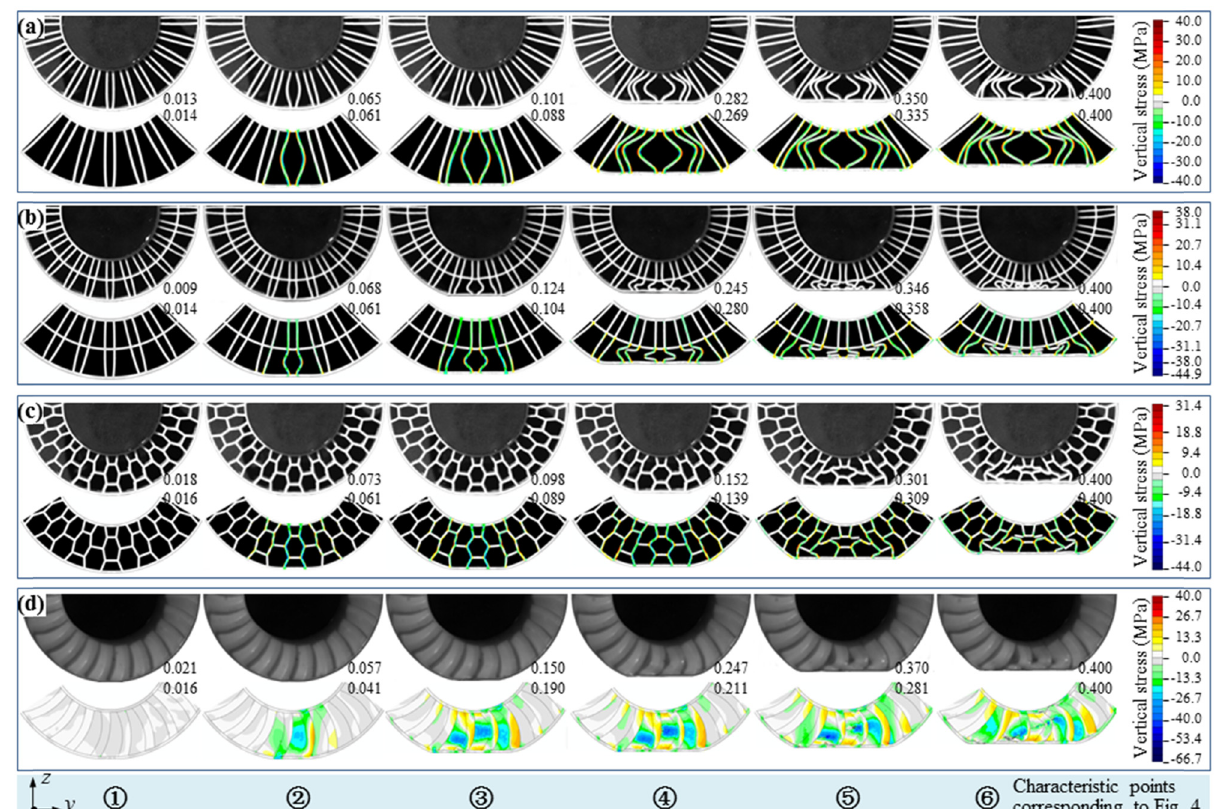
Figure 5: Evolution of the tire shape as obtained from the camera images and FEM simulation results, for six strain points and each tire: ( a ) Tweel; ( b ) Tweel - 2; ( c ) honeycomb; and ( d ) saddle. The stress levels, in color scale, were evaluated with FEM models. ( a ) – ( d ) The fi rst rows are the camera images, while the second rows are the FE